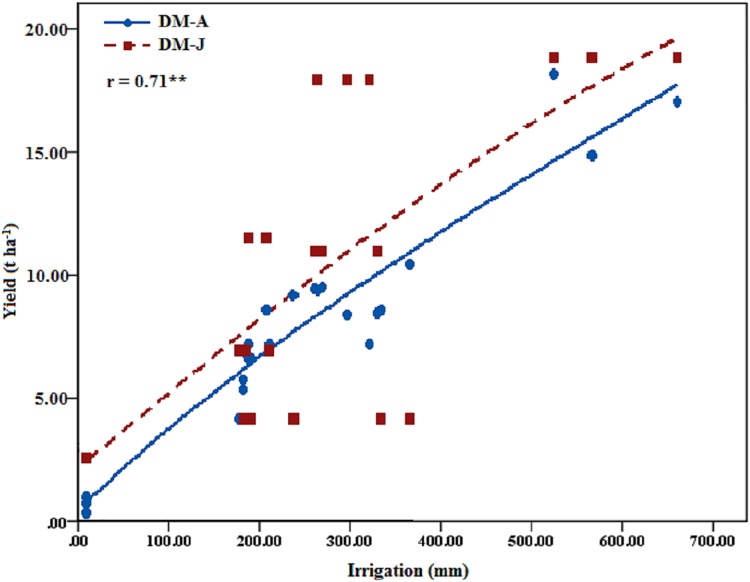
Actual and simulated of alfalfa yield and the relations to the irrigation amount (DM-J, alfalfa yield simulated by Jensen Model, t ha−1; DM-A, actual alfalfa yield, t ha−1).The actual alfalfa yield and simulated yield by Jensen Model were correlated to the amount of irrigation, respectively, and the results are shown. **show that the confidence interval is α = 0.05.